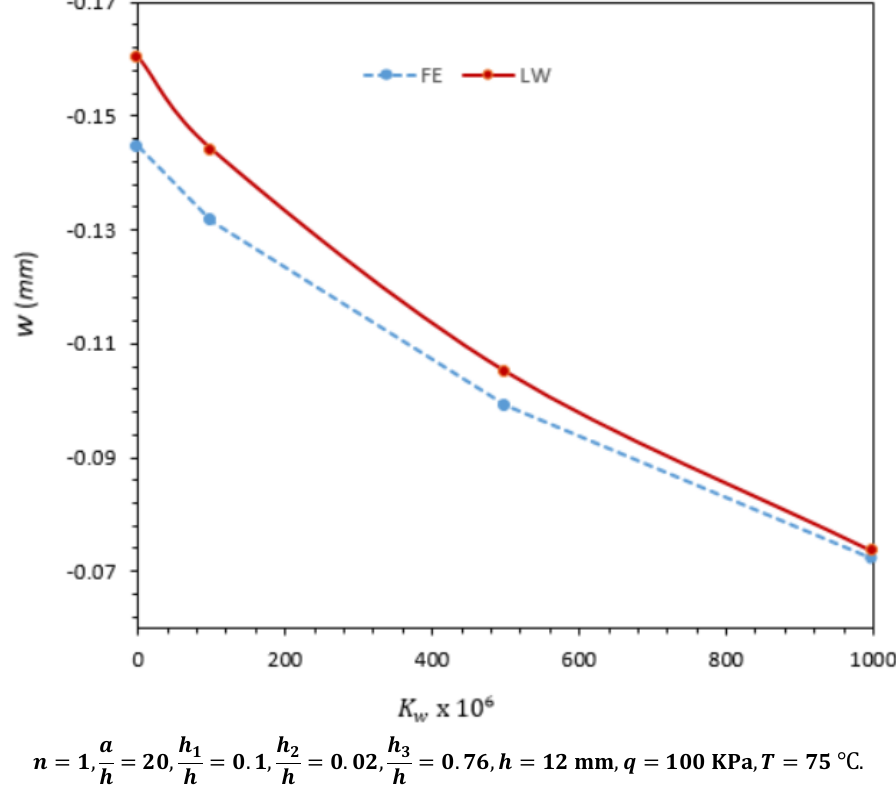
Figure 7. Effect of the elastic foundation on the center deflection of sandwich plate.